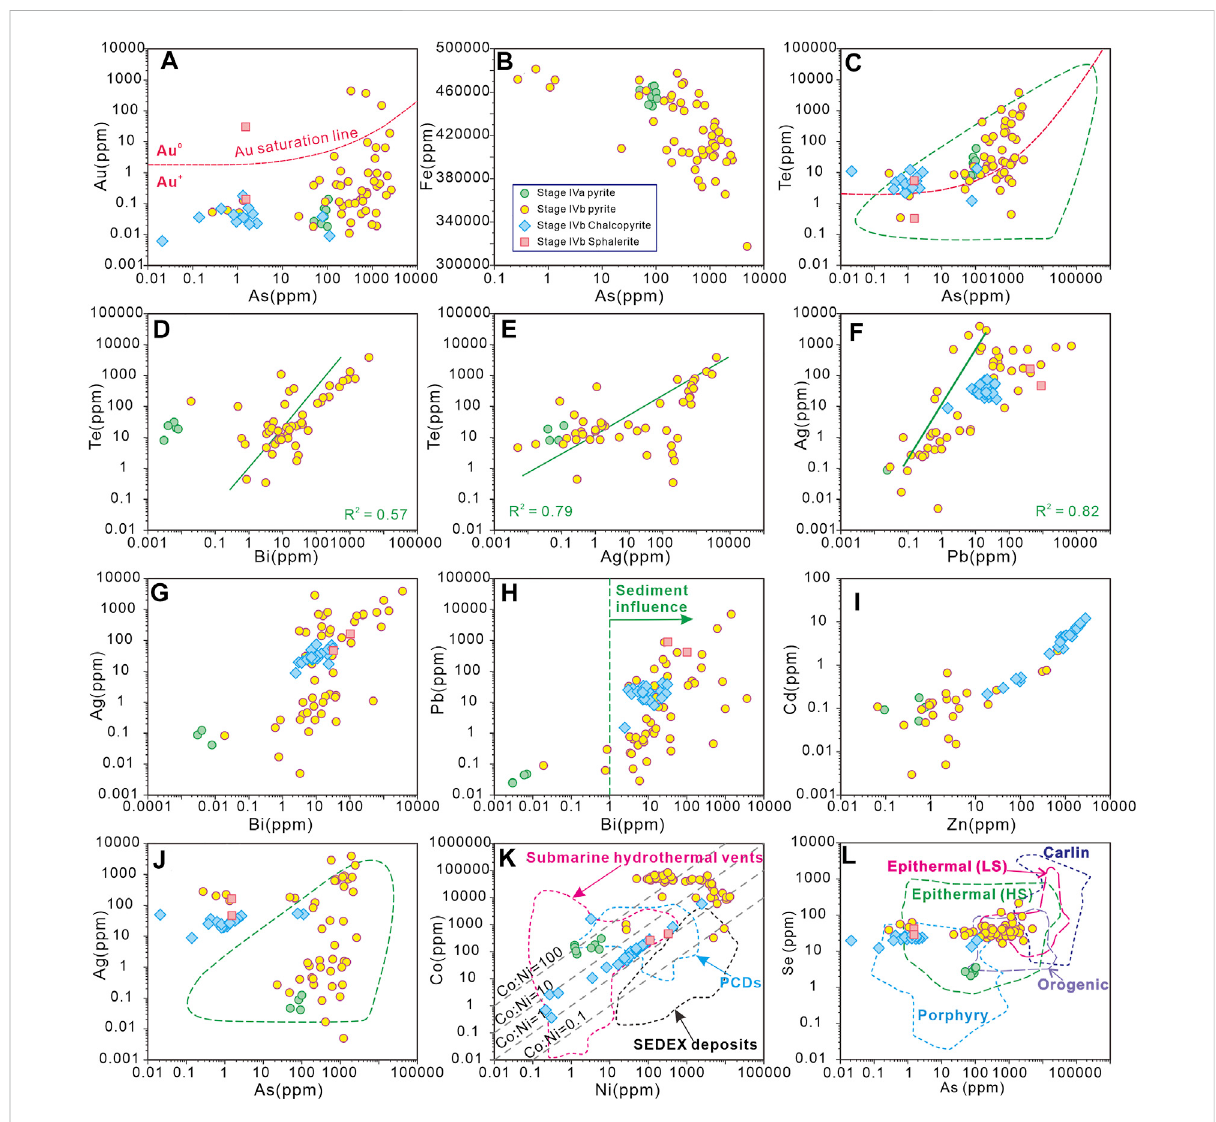
FIGURE 12 PlotsofvarioustraceelementsinthestudiedpyritefromtheYi ’ nanTongjingAu – Cudeposit. (A) AuvsAs(GoldsaturationlineisfromReichetal., 2005); (B) As vs Fe; (C) As vs Te (The green dashed line de fi nes the wedge-shaped zone indicating Te solid solution for pyrites. The red dashed line de fi nesthesolubilitylimitforTesolidsolutioninpyriteasafunctionofAs,whichisbasedontheequationpresentedbyReichetal.(2005)fortheAu- Assystem.); (D) BivsTe; (E) AgvsTe; (F) PbvsAg; (G) BivsAg; (H) BivsPb(afterKeithetal.,2016); (I) ZnvsCd; (J) AsvsAg(Thegreendashedline de fi ne the wedge-shaped zone indicating Ag solid solution for pyrites; Reich et al., 2005); (K) Ni vs Co (Deditius et al., 2013; Cioac ă et al., 2014;